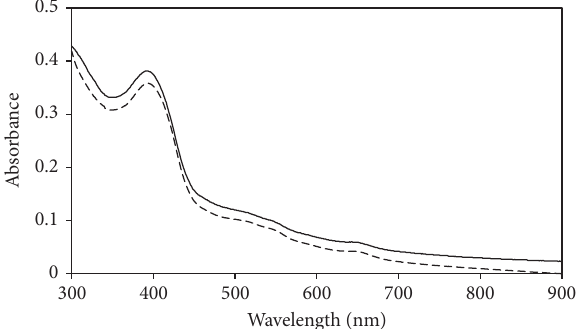
Figure 5: Absorbance spectra of sol-gel entrapped CPO (solid line) and free CPO (dashed line). The silica sol-gel sheet was ∼ 1mm thick and contained 1.6mg/mL CPO. The sheet was placed on the wall of a 10 mm wide plastic cuvette and immersed in 50 mM potassium phosphate buffer, pH 6.0. The solution reference sample was prepared from the same CPO stock via dilution to 0.16 mg/mL (4 𝜇 M) with 50 mM potassium phosphate buffer, pH 6.0 in a 10mm thick plastic cuvette.